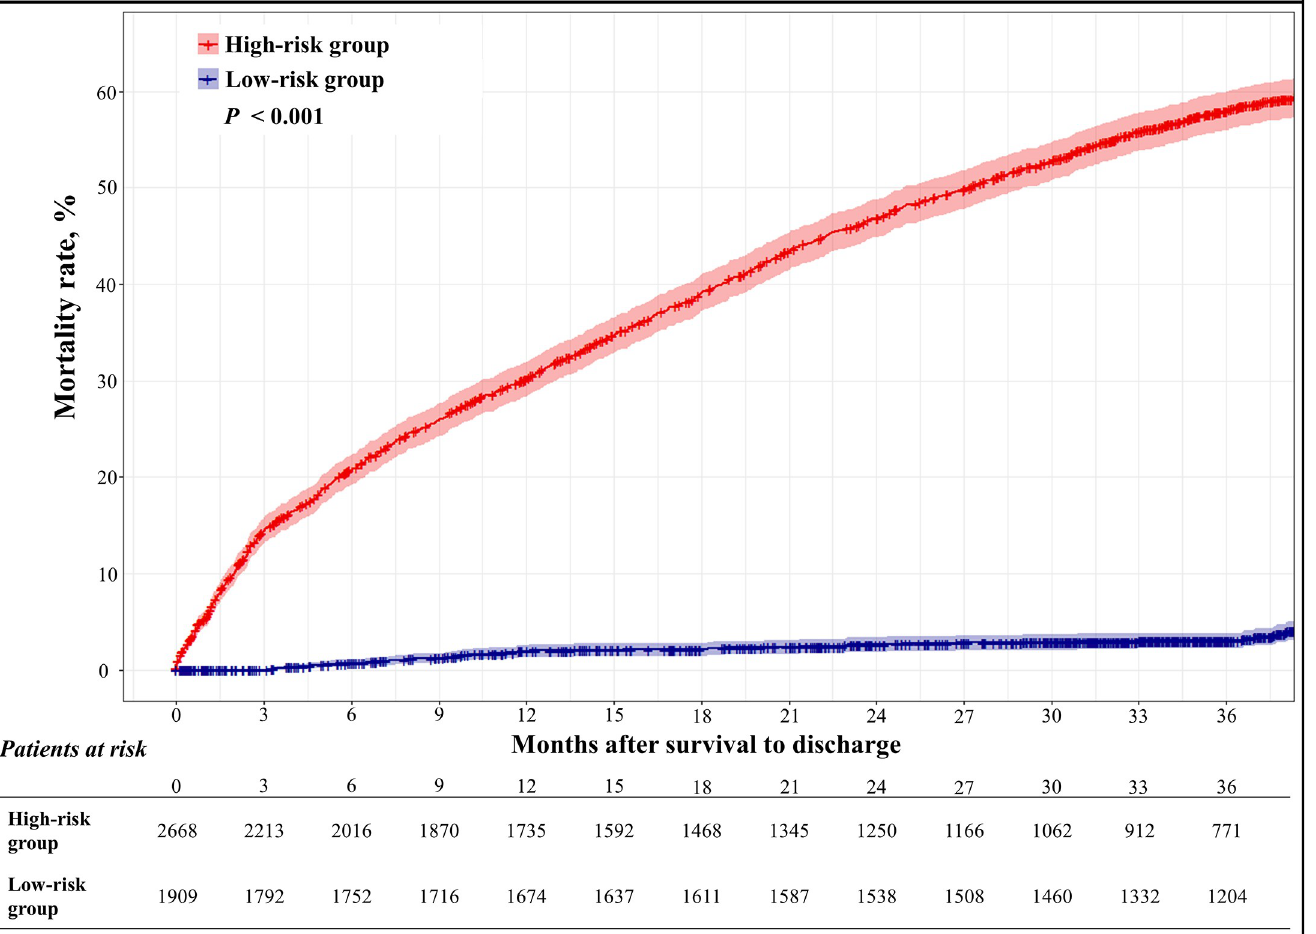
Fig 5. Cumulative hazard of 36-month mortality by deep-learning-based algorithm risk